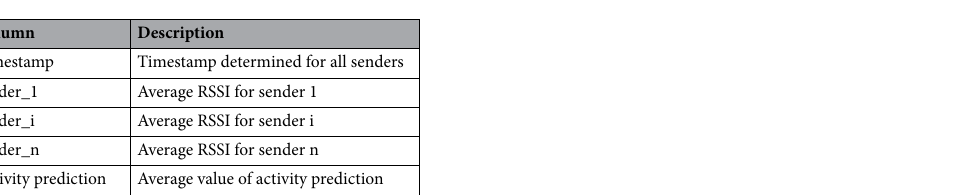
Table 1. Description of columns used in the dataset that can be used for proximity detection compatible with our method.